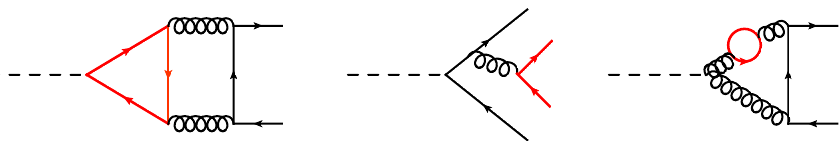
Figure 4. Additional contributions which can arise in H → cc with the addition of a second active heavy quark (bottom) shown in